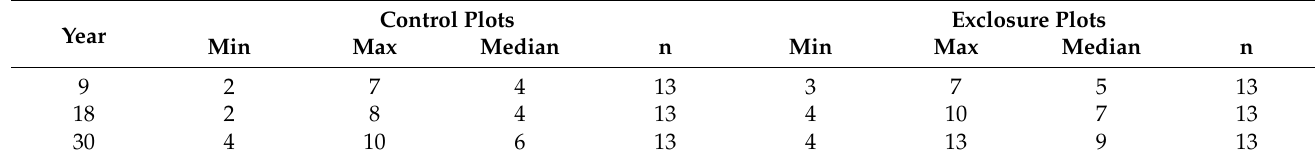
Sample size-based rarefaction and extrapolation sampling curves with 95% confidence intervals for Shannon diversity ( q = 1) and Simpson diversity ( q = 2) levelled off and approached an asymptote, thereby indicating that the number of sampling plots was sufficient to represent frequent and highly frequent height classes of trees in the assemblages (Figure 4). In surveys, that were conducted 9, 18, and 30 years after establishment of study plots, Shannon ( q = 1) and Simpson ( q = 2) diversity estimates of tree height classes showed that tree height class diversity was significantly higher in exclosure plots in comparison to control plots. Based on the asymptotic results, the difference in observed tree height classes between exclosure and control plots was 2.20, 3.98, and 10.63 with respect to frequent height classes ( q = 1) 9, 18, and 30 years after establishment of study plots, respectively (Table 5, Figure 4). The difference with respect to highly frequent tree height classes ( q = 2) between exclosure and control plots increased from 2.17 to 4.33 and 9.94 in the 9, 18, and Table 4. Descriptive statistics (min, max, median) of height class richness (number of tree height 30 years after establishment of study plots (Table 5, Figure classes detected) on the 13 control and 13 exclosure plots, depicted for three points of time within the 30-year study period.